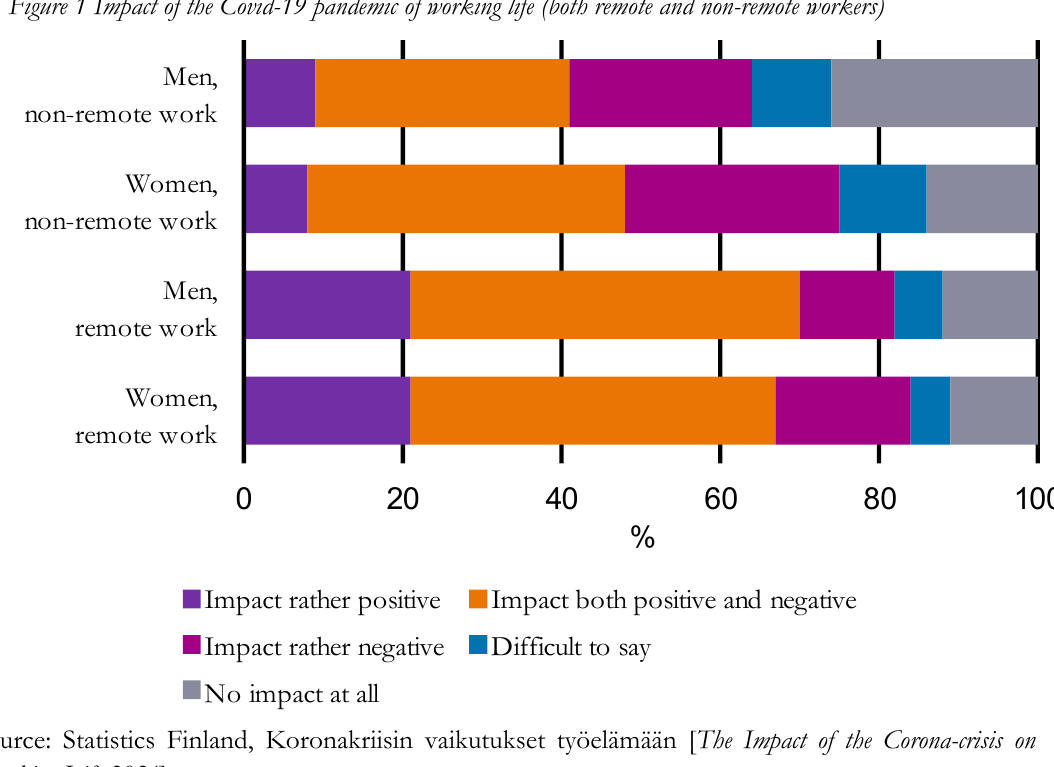
Figure 1 Impact of the Covid-19 pandemic of working life (both remote and non-remote workers)